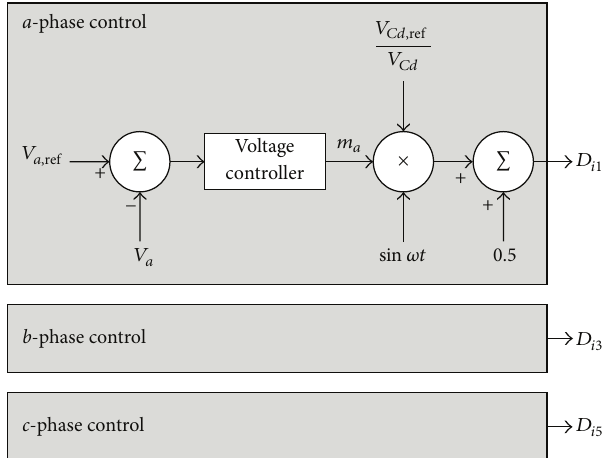
Figure 5: Control-block diagram of the inverter at islanding